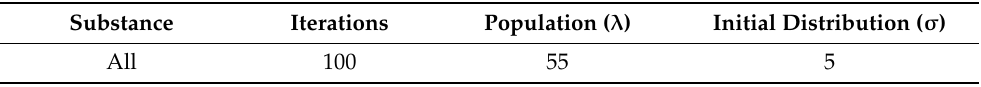
Table 8. Parameters of the simulation for the fitting of enthalpy and entropy. Substance Iterations Population ( λ ) Initial Distribution ( σ